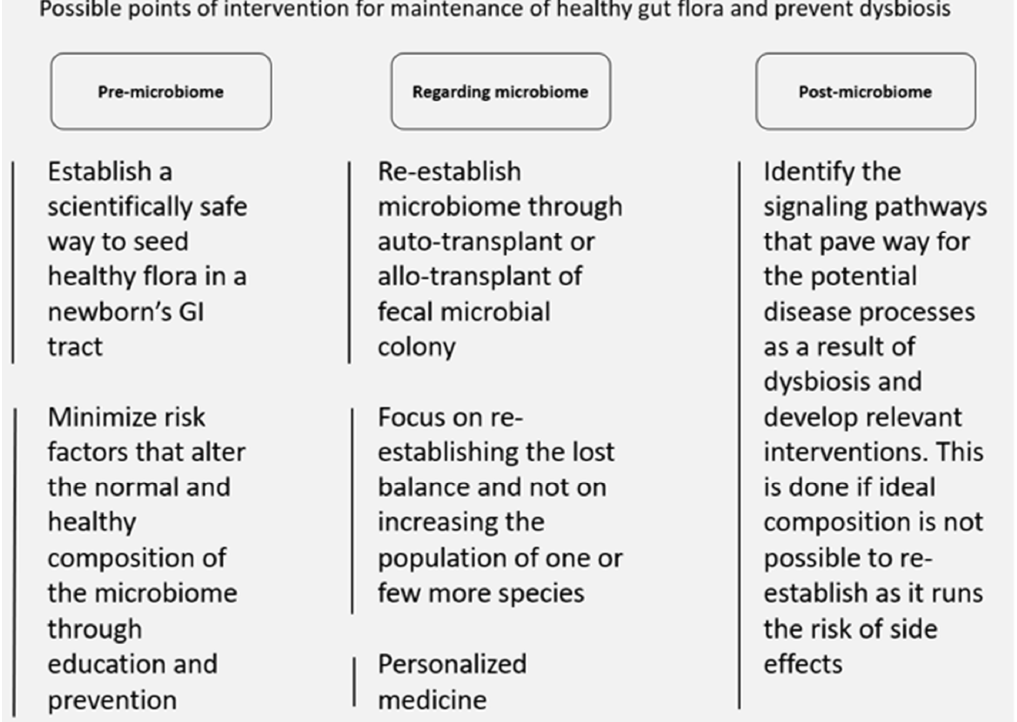
Figure 3. Proposed interventions that may help maintain microbiome, leading to homeostasis in the brain and the body. brain and the